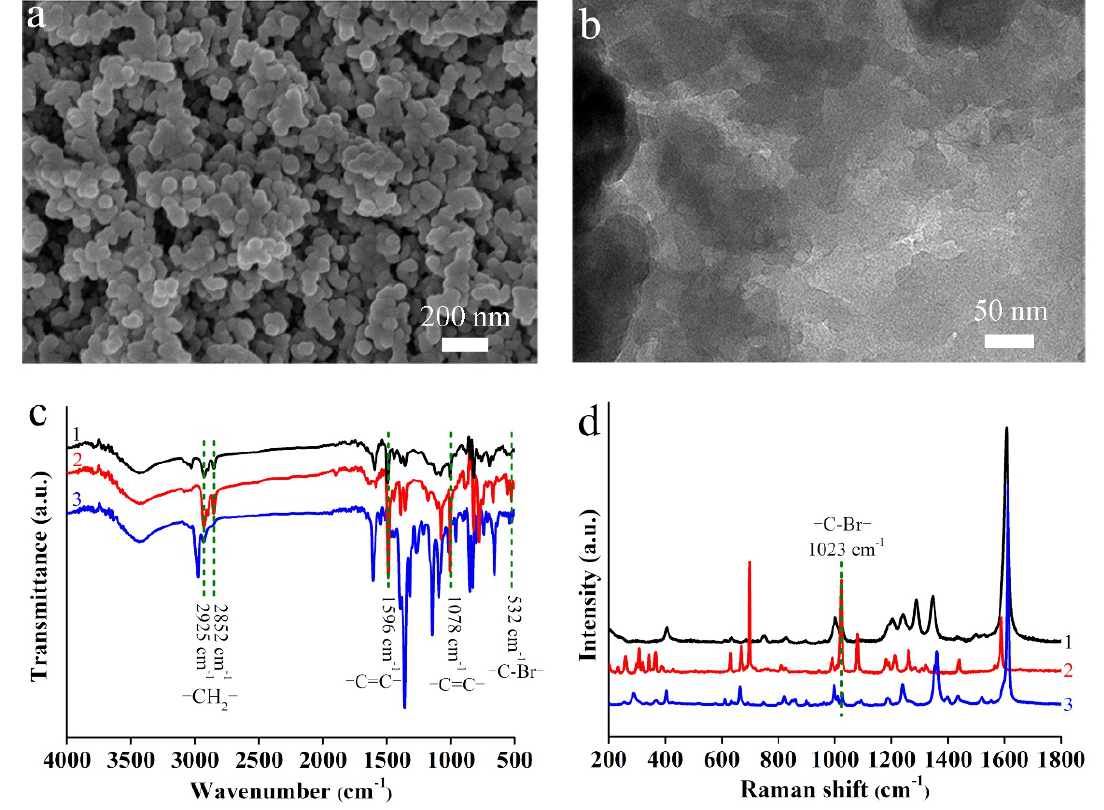
Figure 2. ( a ) SEM and ( b ) TEM images of AdaPOF; ( c ) FT–IR spectra of AdaPOF; ( d ) Raman spectra of AdaPOF.